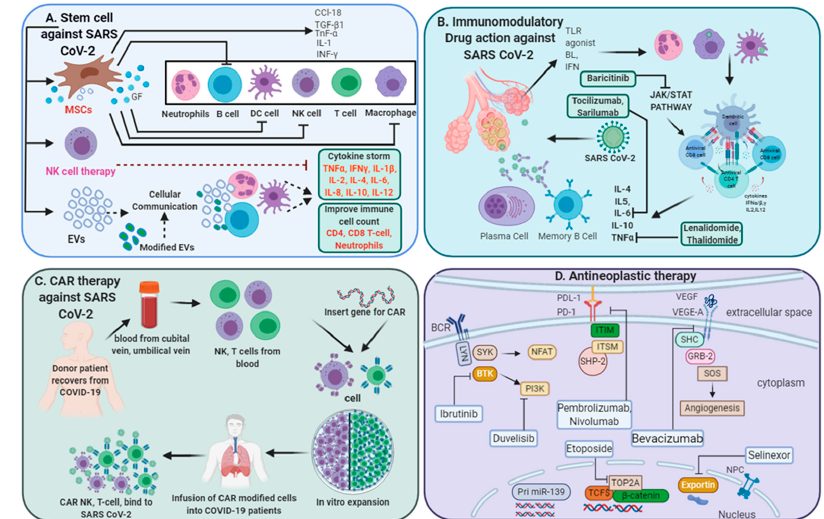
Figure 1. Multi-directive therapeutic intervention currently in clinical trials for combating SARS-CoV-2 pathogenesis. ( A ) Mesenchymal stem cell (MSC) and NK cell-based therapies for the treatment of SARS CoV-2 pathogenesis. Extracellular vesicles (EVs) derived from MSCs or modified exosomes containing antiviral / anti-inflammatory drugs or respective nucleic acid for therapeutic intervention to against SARS-CoV-2 infection. ( B ) Cytokine storm development is a central pandemic delinquent in SARS-CoV-2 infection. Certain immunomodulatory agents with excellent safety profiles or current anti-neoplastic interventions ( D ) may be considered for use in combination with antiviral drugs for the treatment of severe or critical COVID-19 cases. ( C ) Importantly, engineered immune cell receptors, including the chimeric antigen receptor (CAR) T-cell, NK cell therapy, o ff er new therapeutic approaches for SARS-CoV-2 infection. These immune cells collected from recovered patients o ff er an advantage transmit high proliferative e ffi ciency and anti-viral e ffi